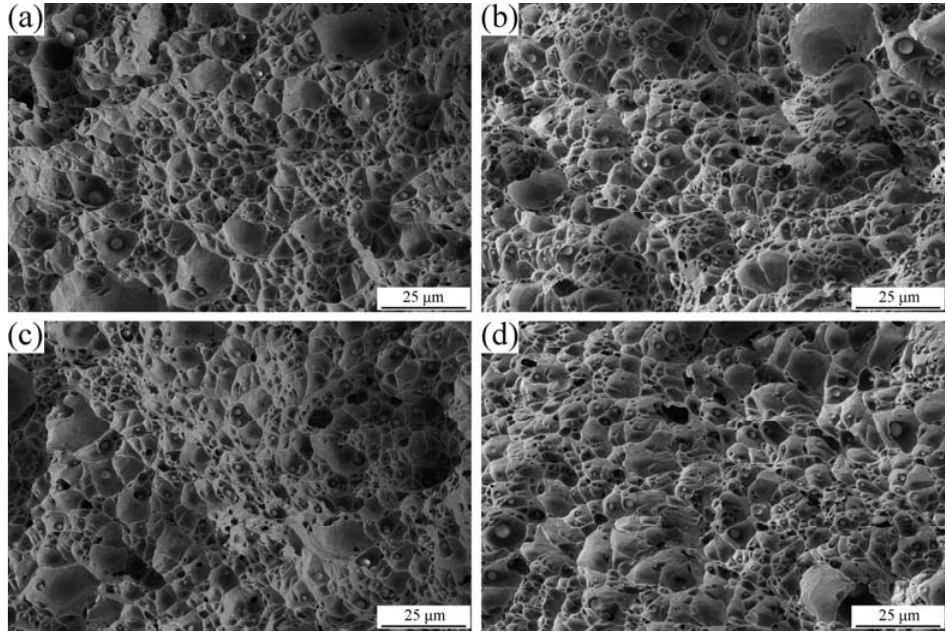
Figure 17. Impact fracture surface with different pulse frequencies at a constant excitation voltage of 40 V: ( a ) 20 kHz; ( b ) 40 kHz; ( c ) 50 kHz; ( d ) 60 kHz.